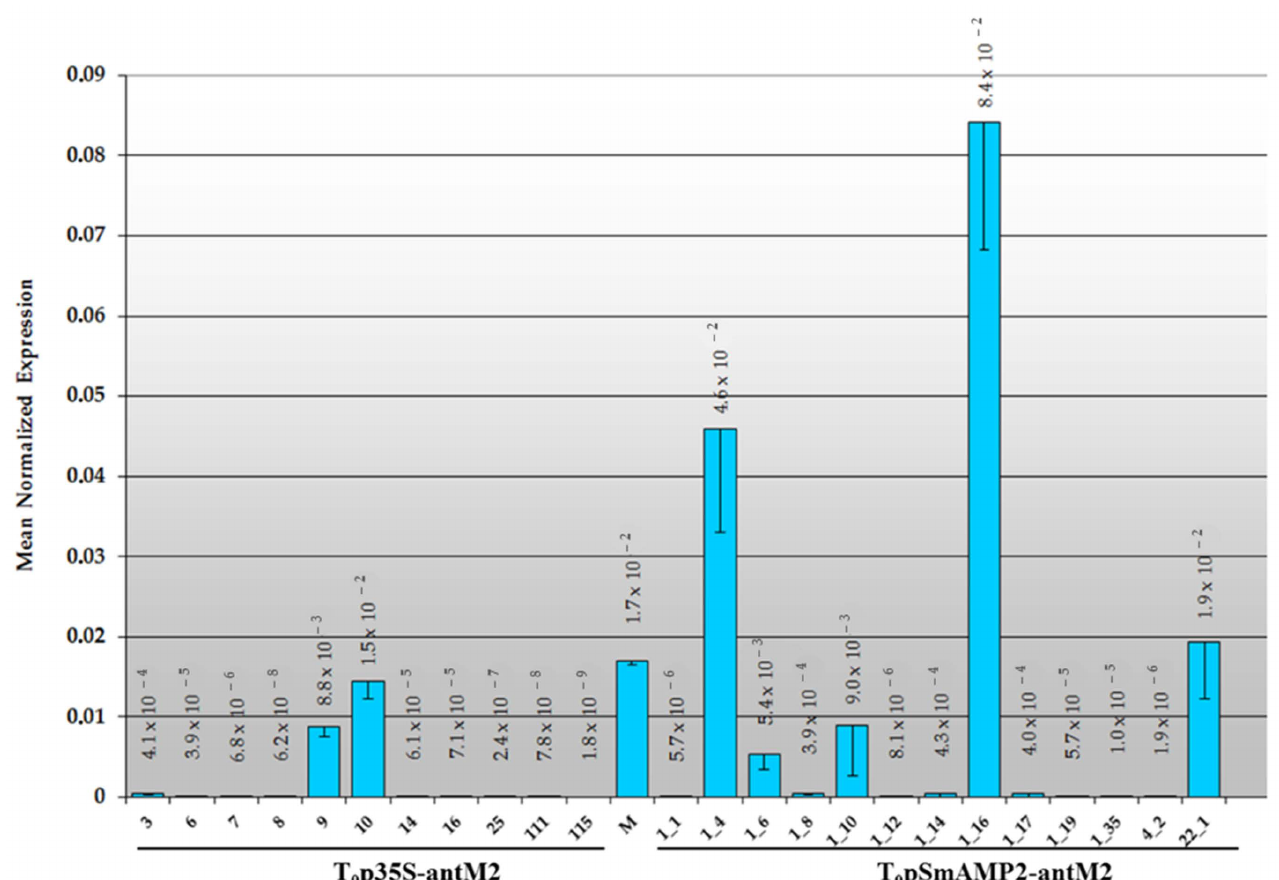
Figure 4. Expression of the MSH2 gene, normalized relative to that of the Actin gene, in tomato leaves under “long-day” (16 h light/8 h dark) conditions based on real-time PCR results. “M” means intact plants from the Marglobe line (control). The numbers below the abscissa axis show the designations of the individual transformants. The vertical lines show the standard